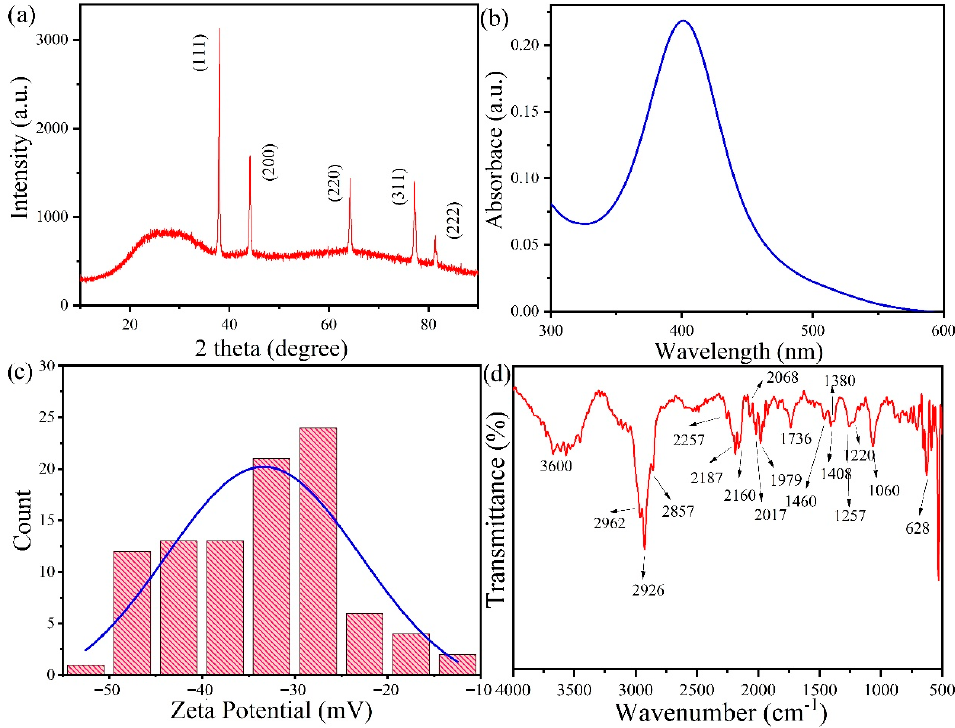
Figure 3. ( a ) X-ray Diffraction Spectroscopy of chemically synthesized silver nanoparticle, ( b ) UV-Vis’s absorption spectrum of silver nanoparticles, ( c ) Zeta potential of chemically synthesized silver nanoparticle, and ( d ) FTIR spectrum scan of chemically synthesized silver nanoparticle.